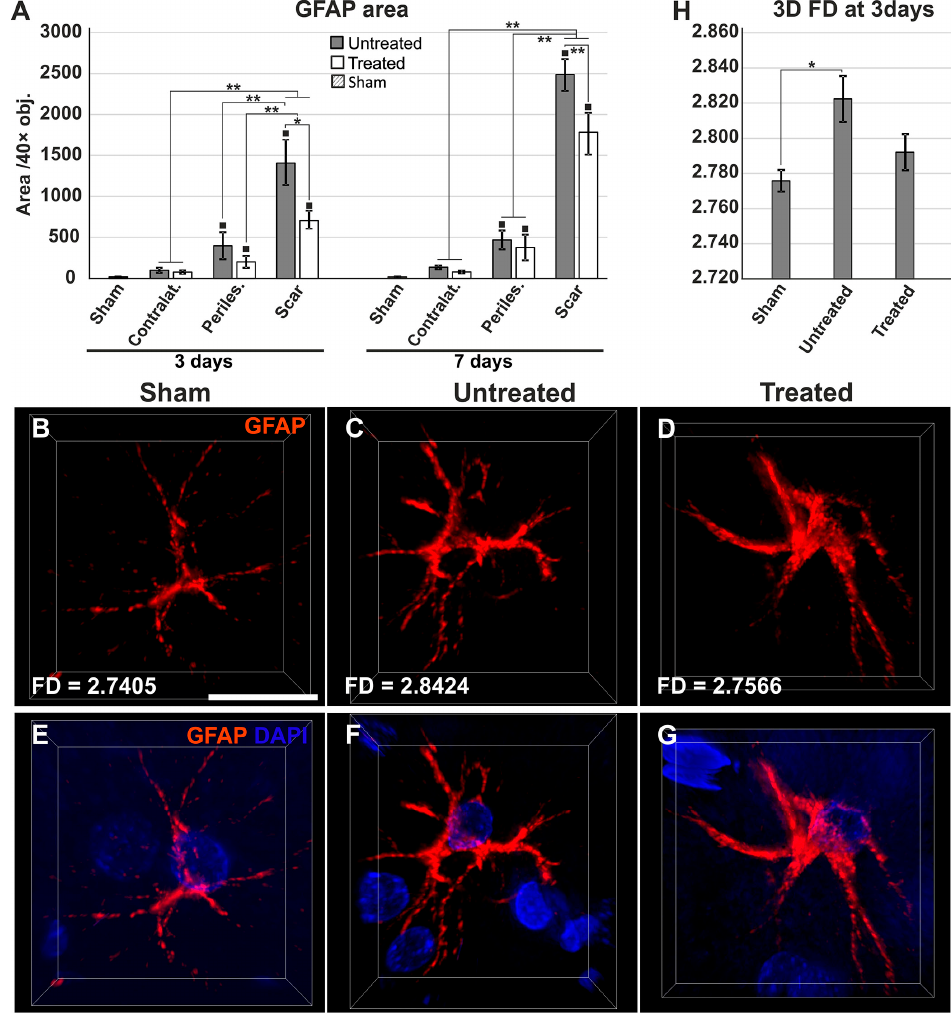
Figure 3. Increased astrogliosis and different astroglial morphologies in untreated animals compared to the treatment group. ( A ) Gliotic areas increase from the contralateral hemisphere to the ipsilateral hemisphere and the scar region, where they are significantly higher for untreated animals compared to treated rats, for 3-day and 7-day survival times (* p < 0.05, ** p < 0.01; ■ p < 0.01 (for pathological regions versus sham animals), using a one-way ANOVA followed by a post hoc Fisher’s LSD test, n = 5–6/group). The differences between 3 and 7 days are not included for reasons of clarity; ( B – D ) Representative three-dimensional projections of scar astrocytes show different morphologies and 3D fractal dimension values (FD) for the sham, untreated, and treated animals at 3 days; E – G images include also the DAPI nuclear morphology for better orientation; ( H ) Due to the high diversity of the astrocyte morphologies, three-dimensional FD values could only differentiate between sham and untreated astrocytes (F(2,16) = 3.843, * p = 0.047). Data are expressed as the means ± SEM. Scale bars in the micrographs represent 20 µm.